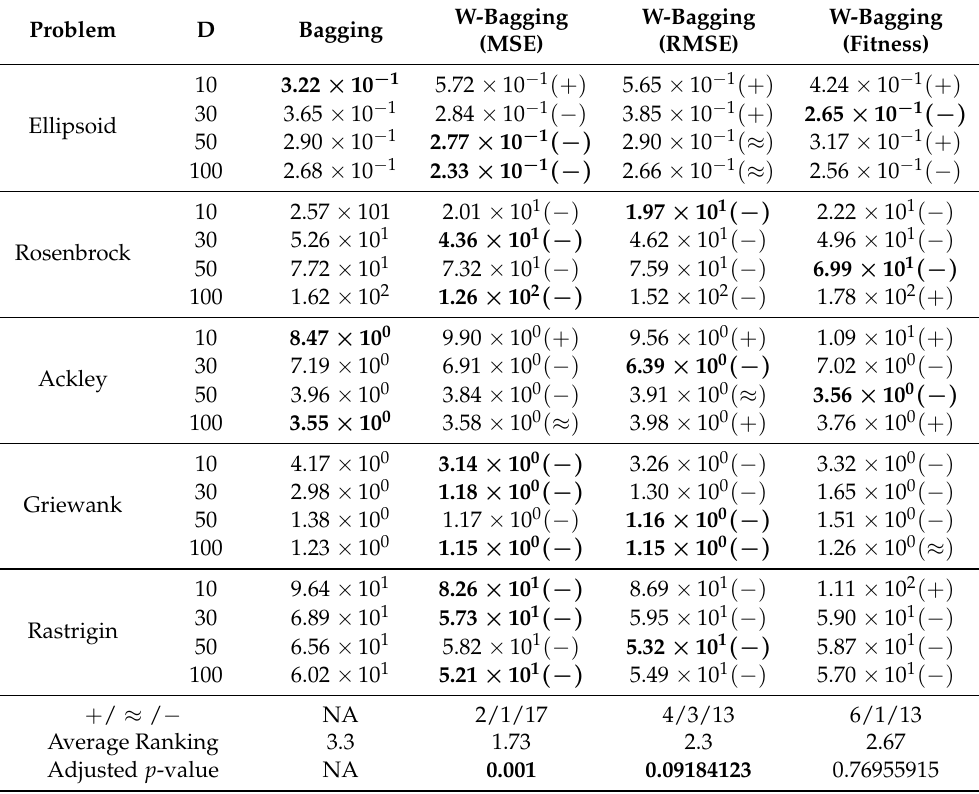
Table 5. The comparisons on optimization results between variants of W-bagging and bagging (the best results and the lowest p -values are shown in